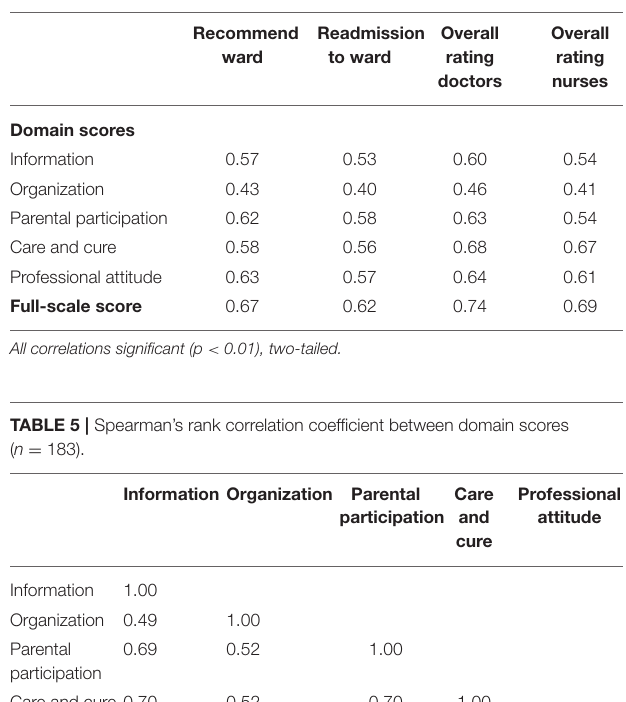
TABLE 4 | Spearman’s rank correlation coefficient between domain scores/ full-scale score and scores on the overall satisfaction items ( n = 183).